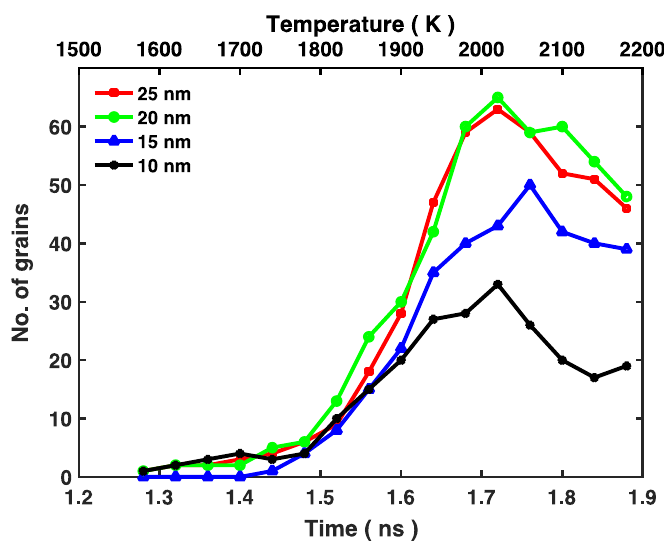
Figure 7. The grain structure (2100 K) resulting from the crystallization of the 10 nm diameter MG nanorod. Colors indicate different grain orientations.